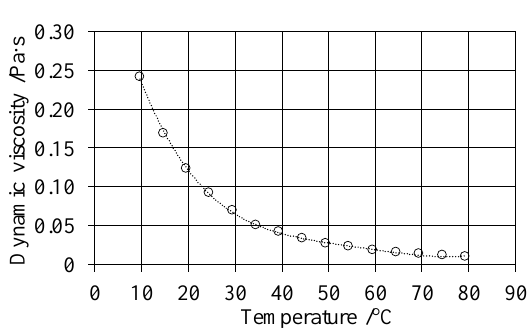
Fig. 1. Dependence of the oil dynamic viscosity  O on the temperature t O .